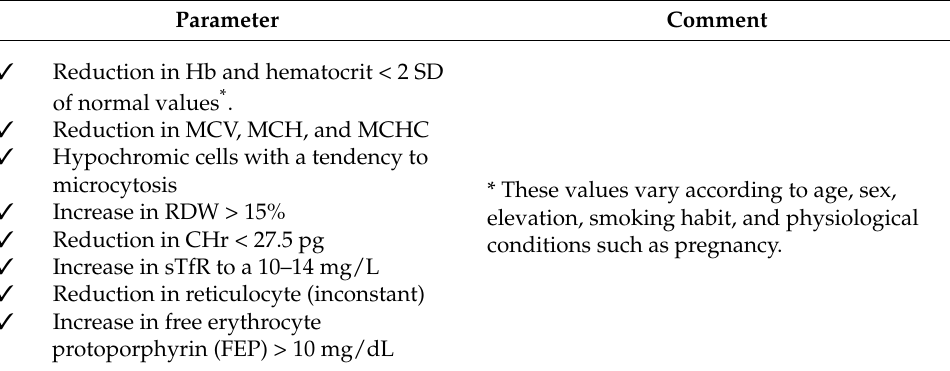
Table 1. Other parameters evaluable for IDA diagnosis